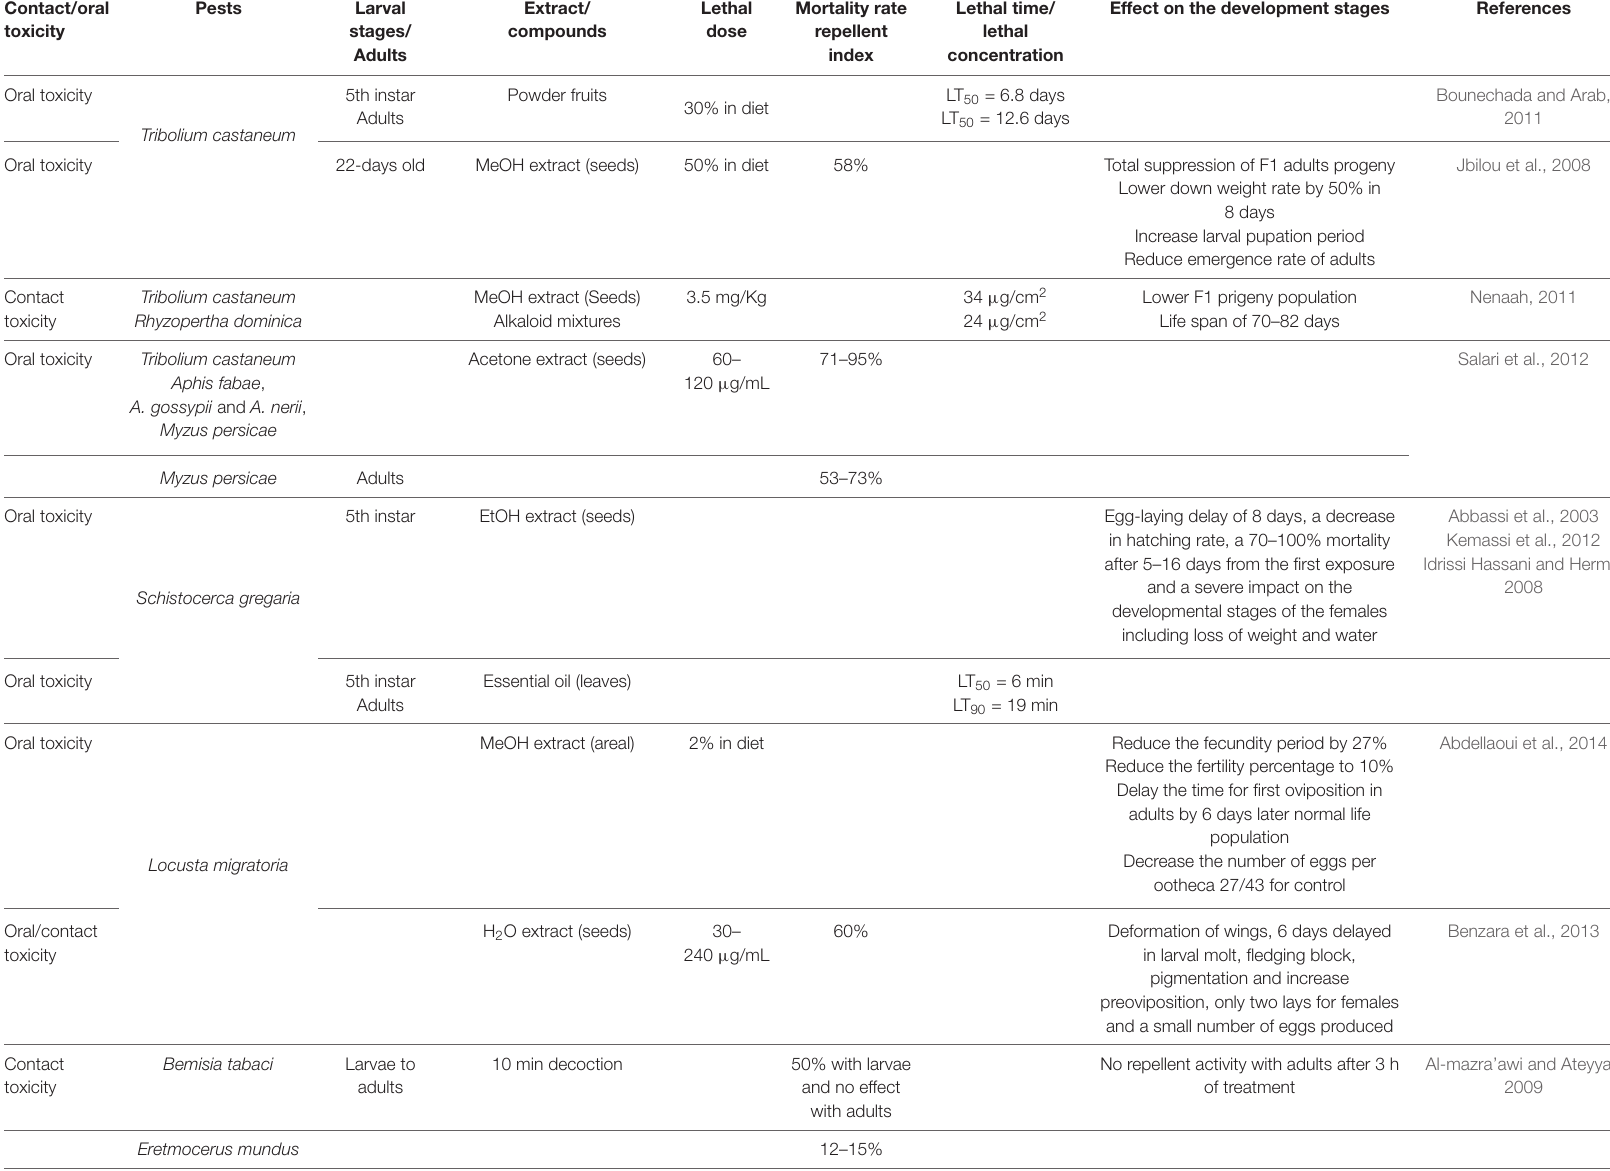
TABLE 1 | Effects of Peganum harmala toward insects and